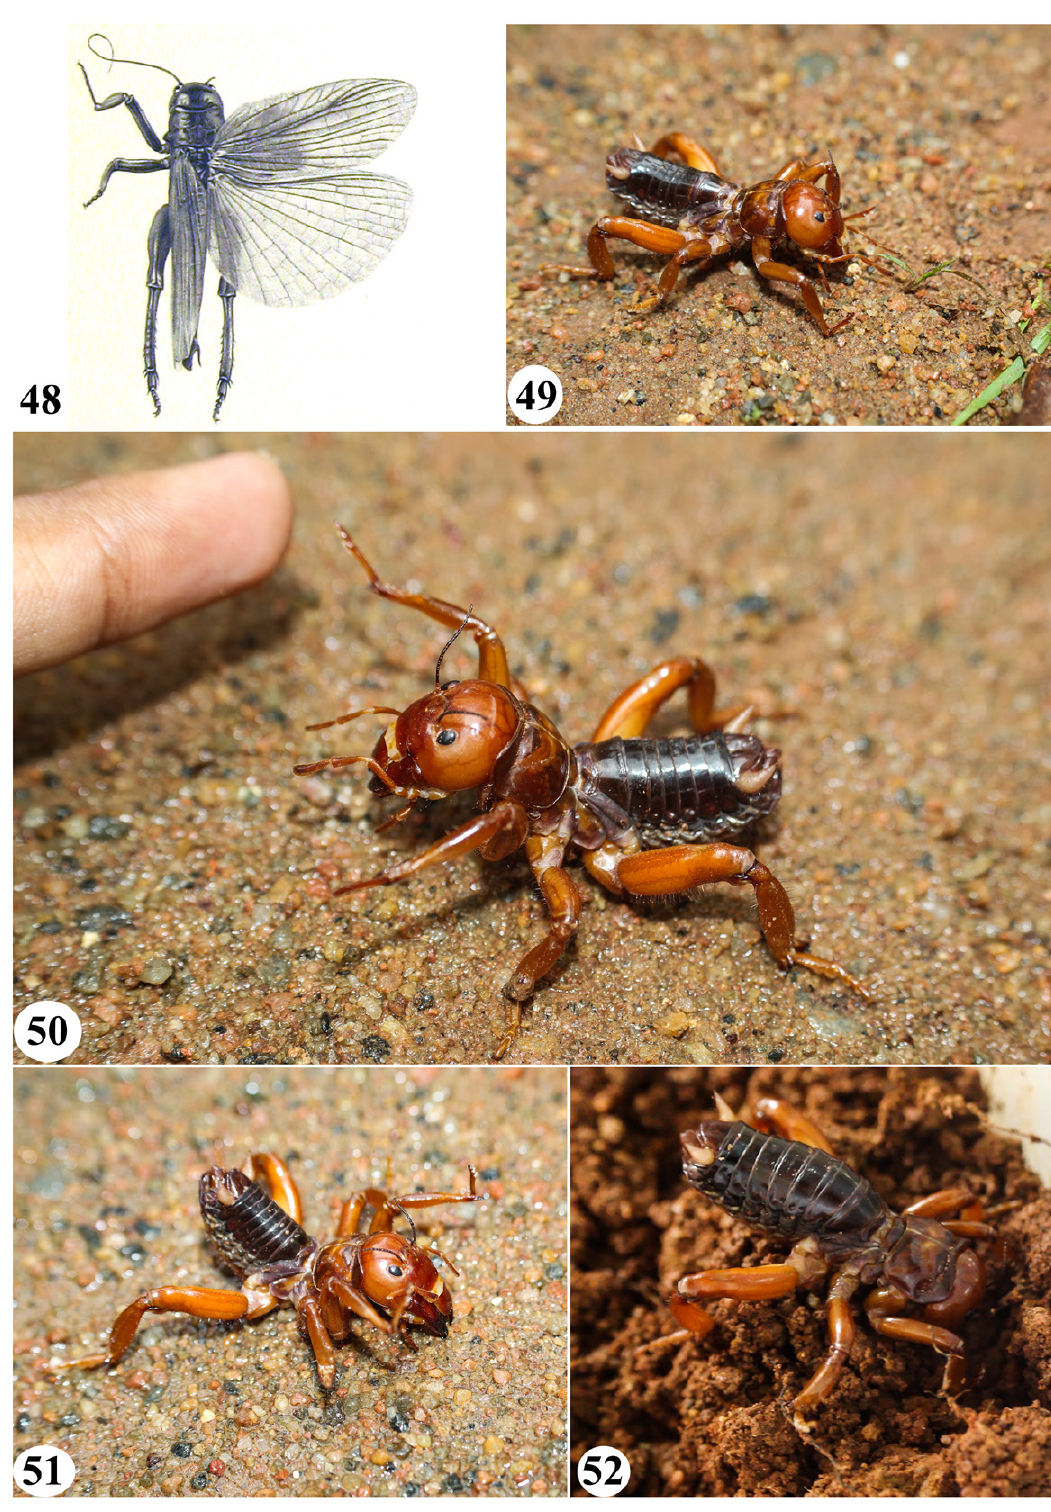
Figs 48–52. Oryctopterus species. 48 . Oryctopterus lagenipes (Karny, 1935), allotype, ♂, from Colombo, Sri Lanka (Karny 1937: pl. 7 fig. 2; available from Orthoptera species file). 49–52 . Oryctopterus varuna sp. nov. 49 . Walking posture. 50 . Defending a frontal attack. 51 . Abdomen and fore-legs raised when poked on thorax. 52 . Initiation of digging. Images not to